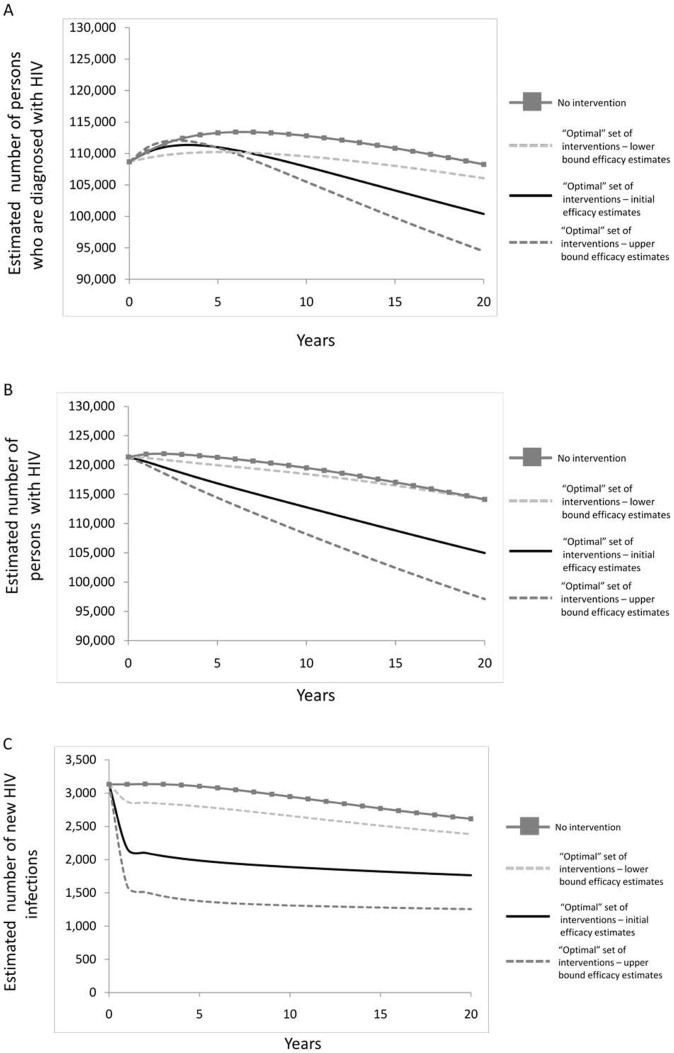
Epidemic curves for 20 year simulation.
Black line- Base case scenario; Grey line- optimized package (Package 7 from Figure 3b) implemented. a. New HIV diagnoses over 20 years. b. HIV prevalence over 20 years. c. HIV incidence over 20 years.